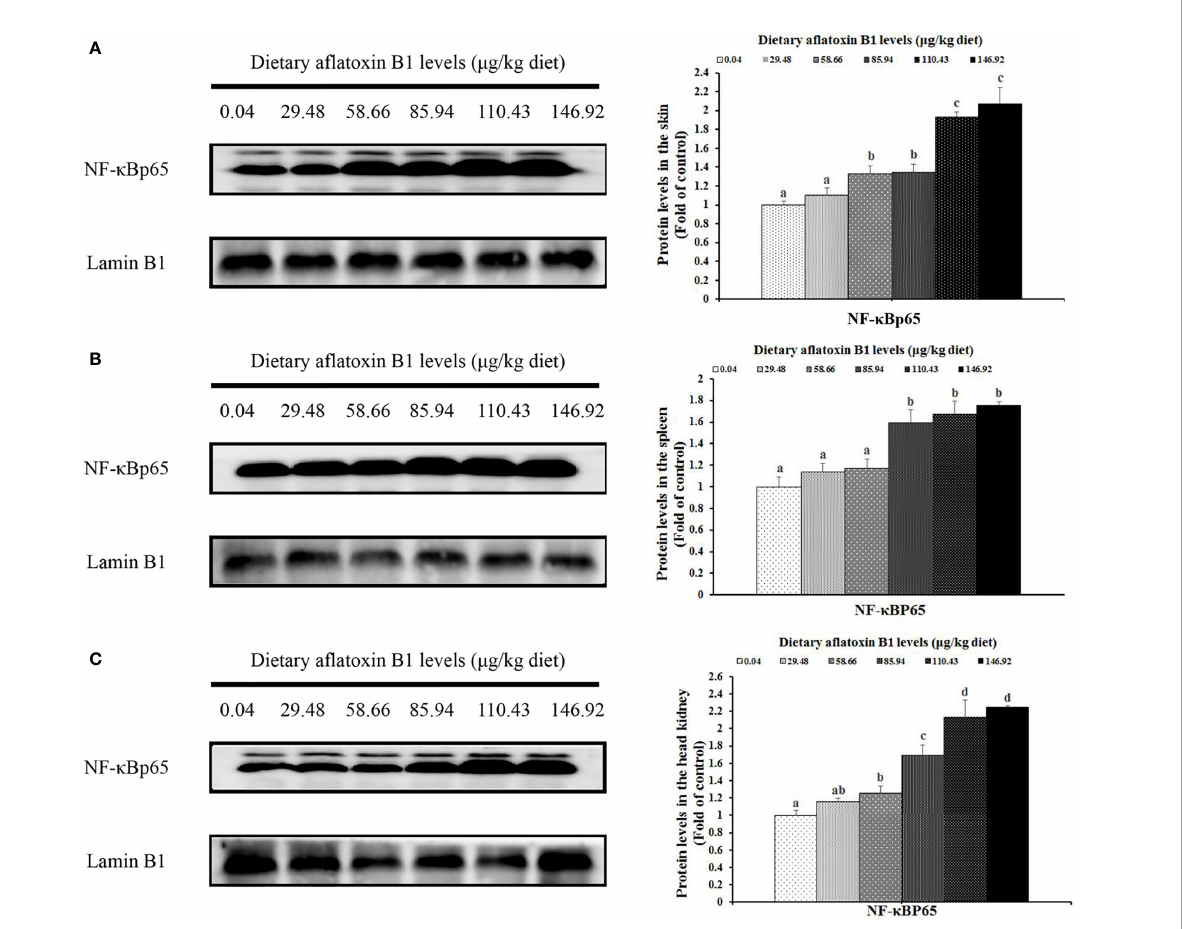
FIGURE 5 The protein levels NF-kB p65 in the skin (A) , spleen (B) and head kidney (C) of grass carp after infection of A hydrophila . n=6 (six fi sh in each group). Different letters indicate signi fi cant differences (P <